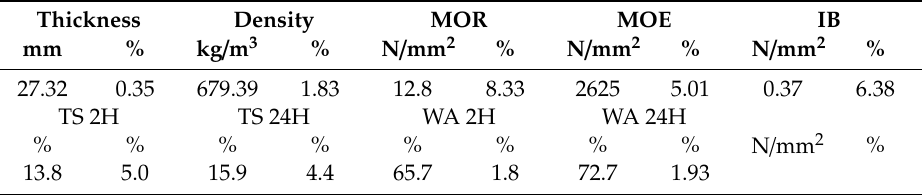
Table 8. Properties of three-ply chip-sawdust board.